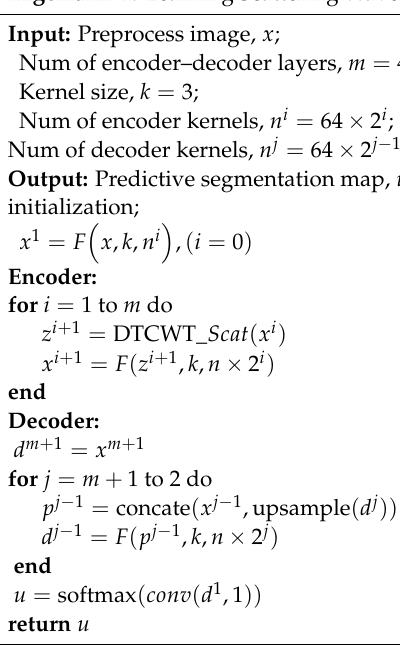
Algorithm 1: Learning Scattering Wavelet Network